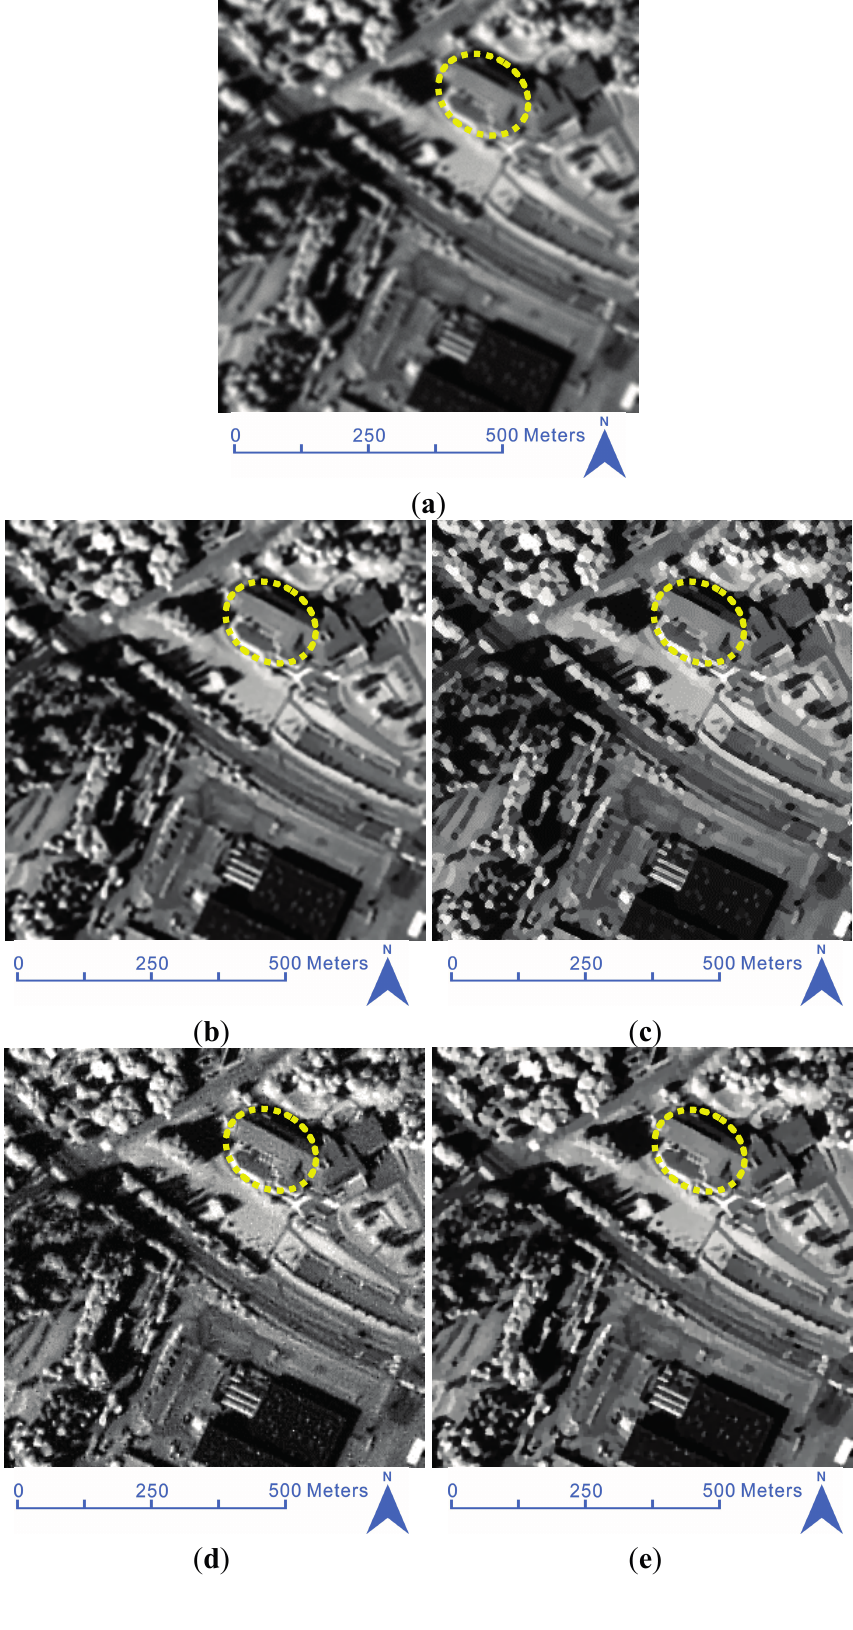
Figure 8. Comparison of the results for the SPOT image in the noisy case: ( a ) degraded image by a 5 × 5 truncated Gaussian PSF, and WGN with a variance of 3; ( b ) restored image of the MLO method; ( c ) restored image of the AM-Sparse method; ( d ) restored image of the AM-HMRF method; ( e ) restored image of the AM-KEdge